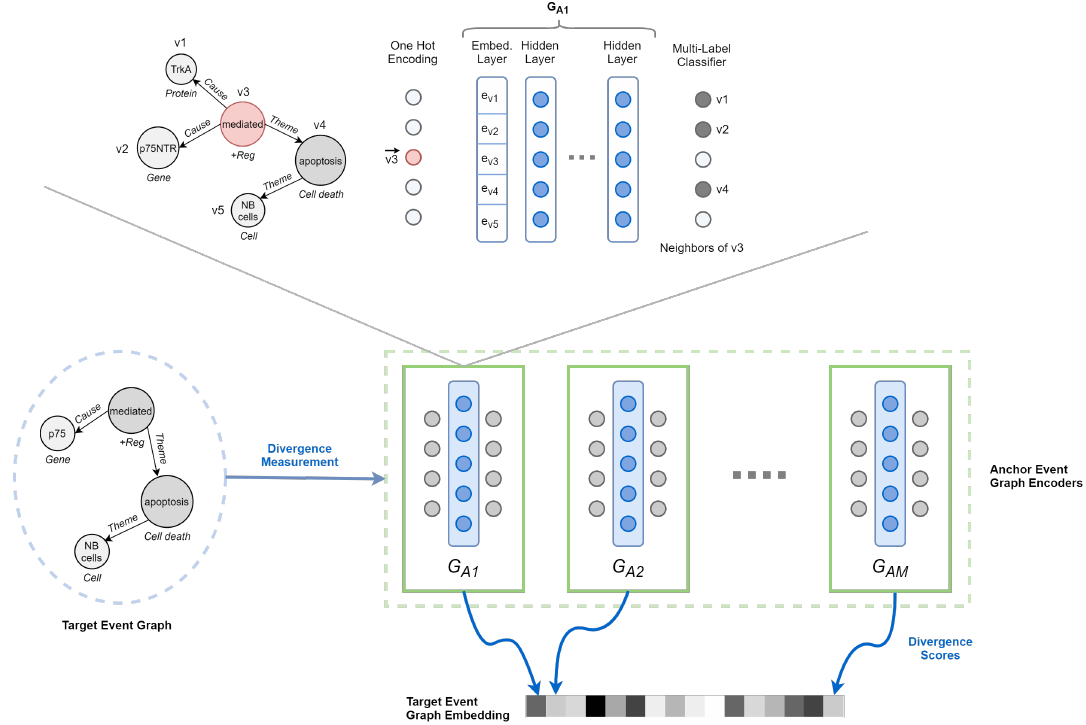
Figure 6. Overview of DDEGK. Structural and semantic divergence scores from a set of anchor event graphs are used to compose the vector representation of a target event graph. Divergence is measured through pre-trained Node-to-Edges encoder models, one for each